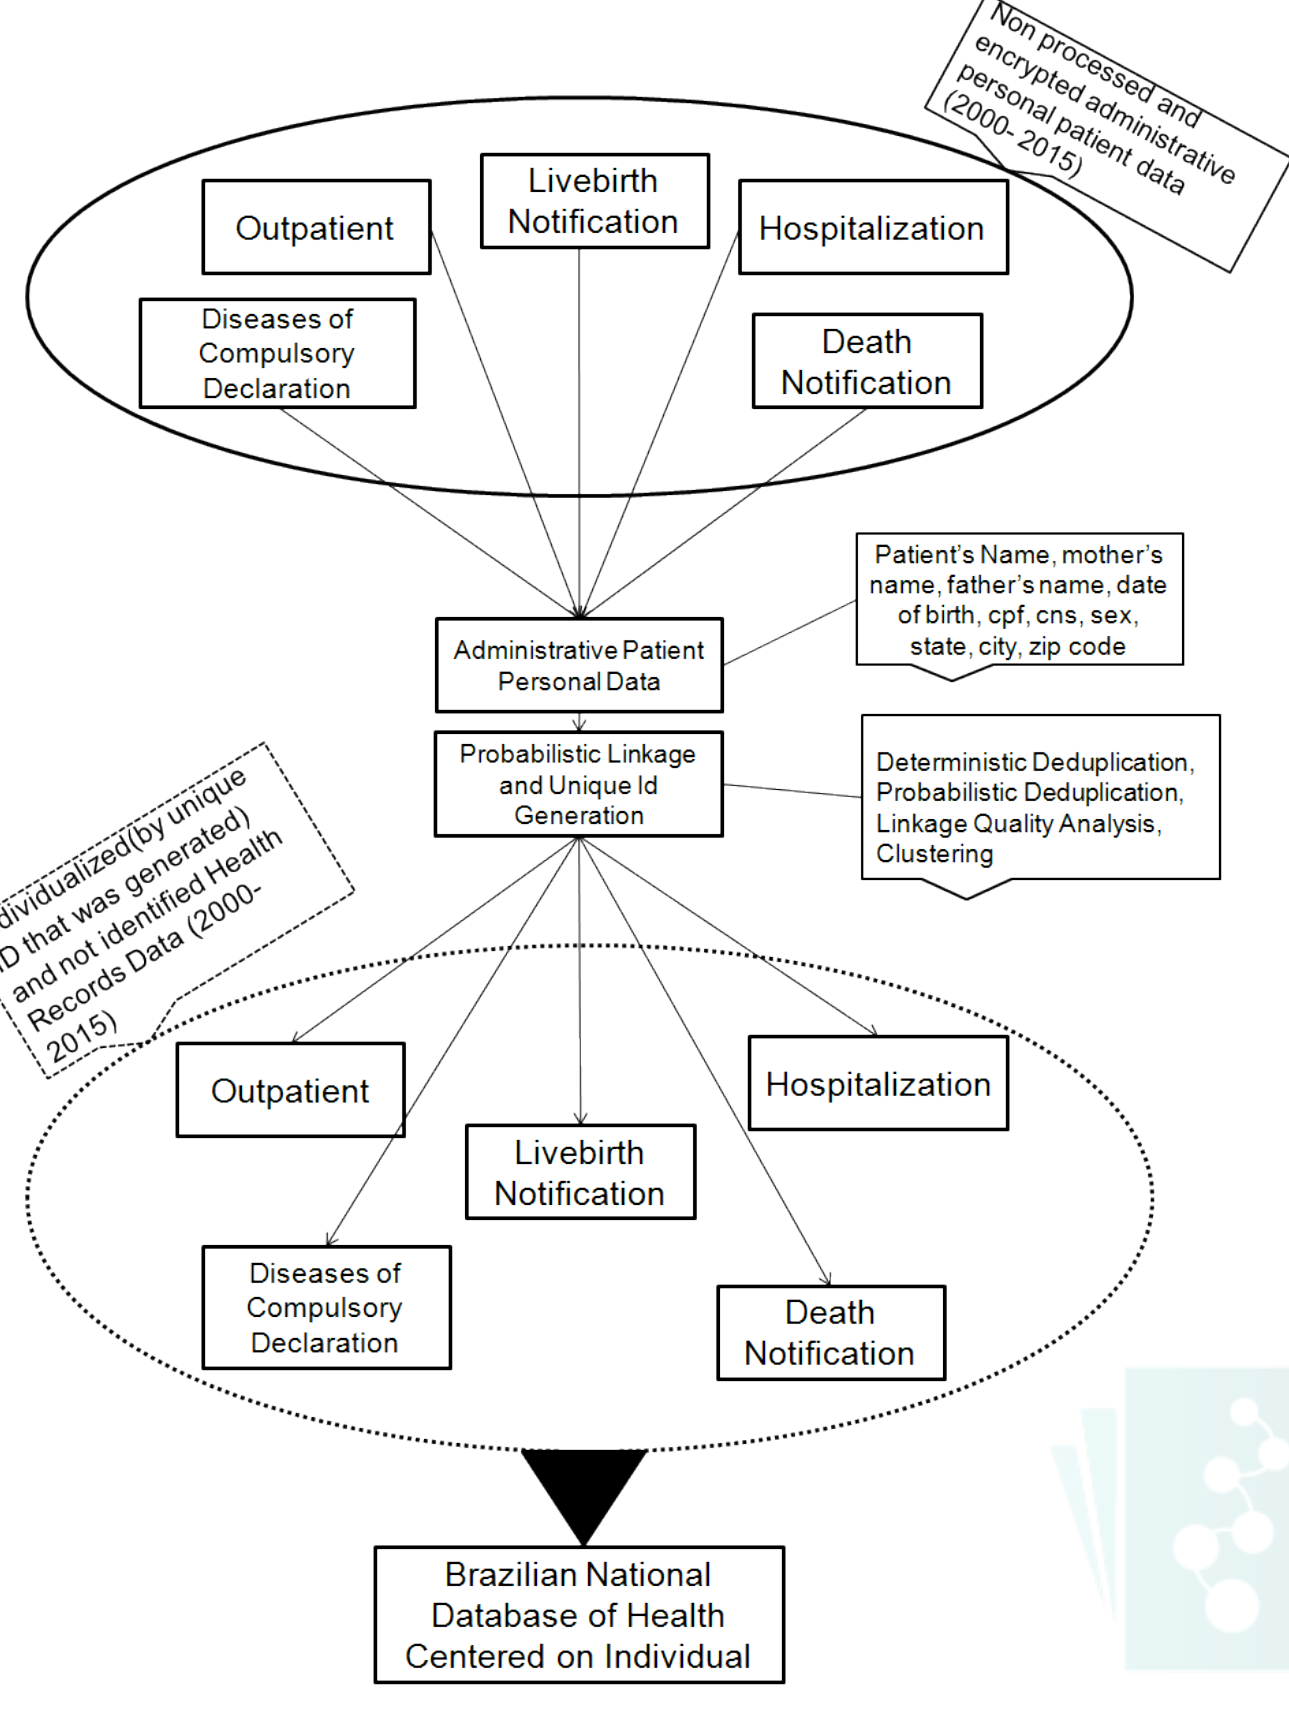
Figure 1: Model proposed to create the Brazilian National Database of Health centred on the